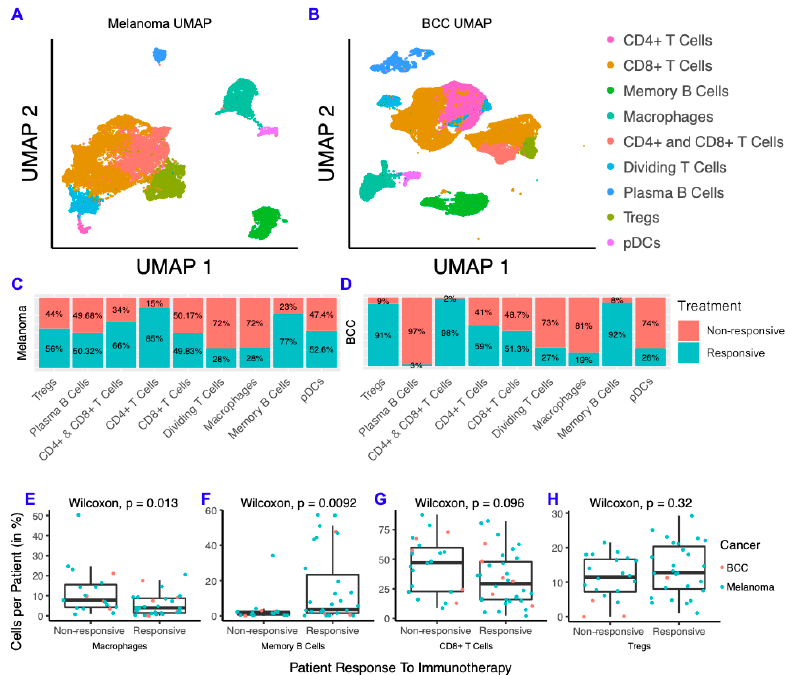
Figure 1. Melanoma and basal cell carcinoma (BCC) have similar responses to immunotherapy. ( A , B ) Dimensionality reduction of melanoma ( A ) and BCC ( B ). ( C , D ) Distribution of cells from responders and non-responders, grouped by cluster. ( E–H ) Percentage of macrophages ( E ), memory B cells ( F ), CD8+ T cells ( G ) and T regulatory cells (Tregs) ( H ) per patient, grouped by responders and non-